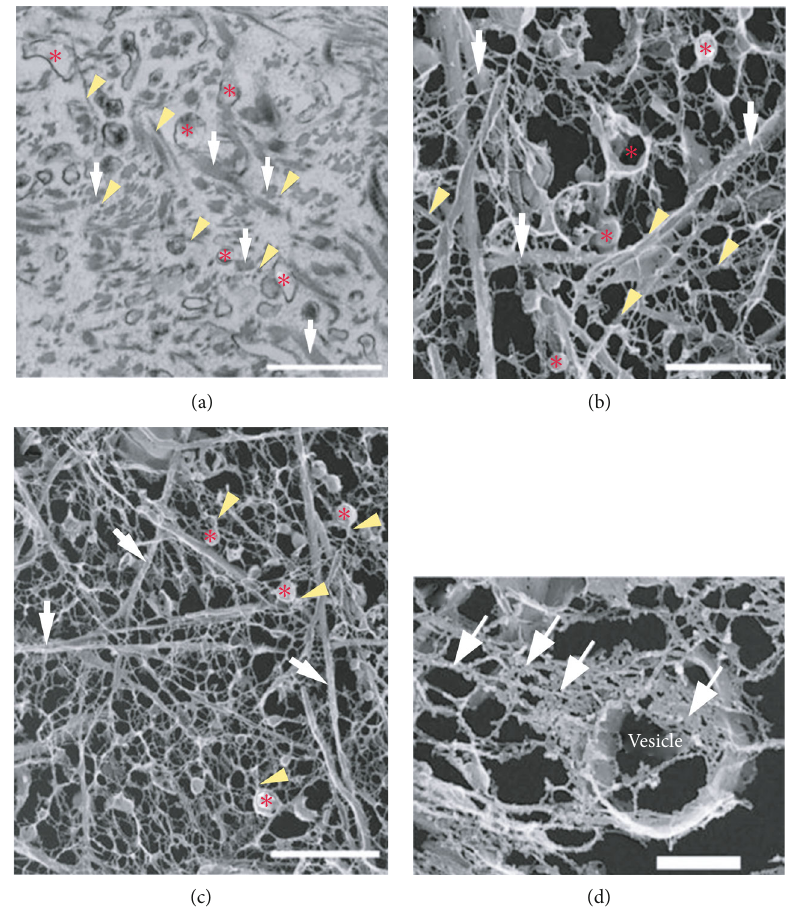
Figure 4: EV-collagen interactions in a reconstituted collagen substrate. (a) TEM image of EVs ( red asterisks ) distributed within the collagen matrix. A number of large collagen aggregates are attributed to PureCol collagen ( white arrows ) with the presence of small fi brils ( yellow arrowheads ). Scale bar = 1 μ m . (b) High-magni fi cation QFDE image shows EVs ( red asterisks ), large fi bril bundles ( white arrows ), and small fi bril bundles ( yellow arrowheads ) present within the collagen matrix. Scale bar = 1 μ m . (c) Low-magni fi cation QFDE image shows EVs ( red asterisks ) connected with small fi bril bundles ( yellow arrowheads ). Large fi bril bundles ( white arrows ) were also present. Scale bar = 2 μ m . (d) High-magni fi cation QFDE image of an EV ( vesicle ) containing matrix components ( white arrows ). Scale bar = 0 : 5 μ m . Images were modi fi ed and reproduced from Saeidi et al. 2012 [57] based on a Creative Commons license,